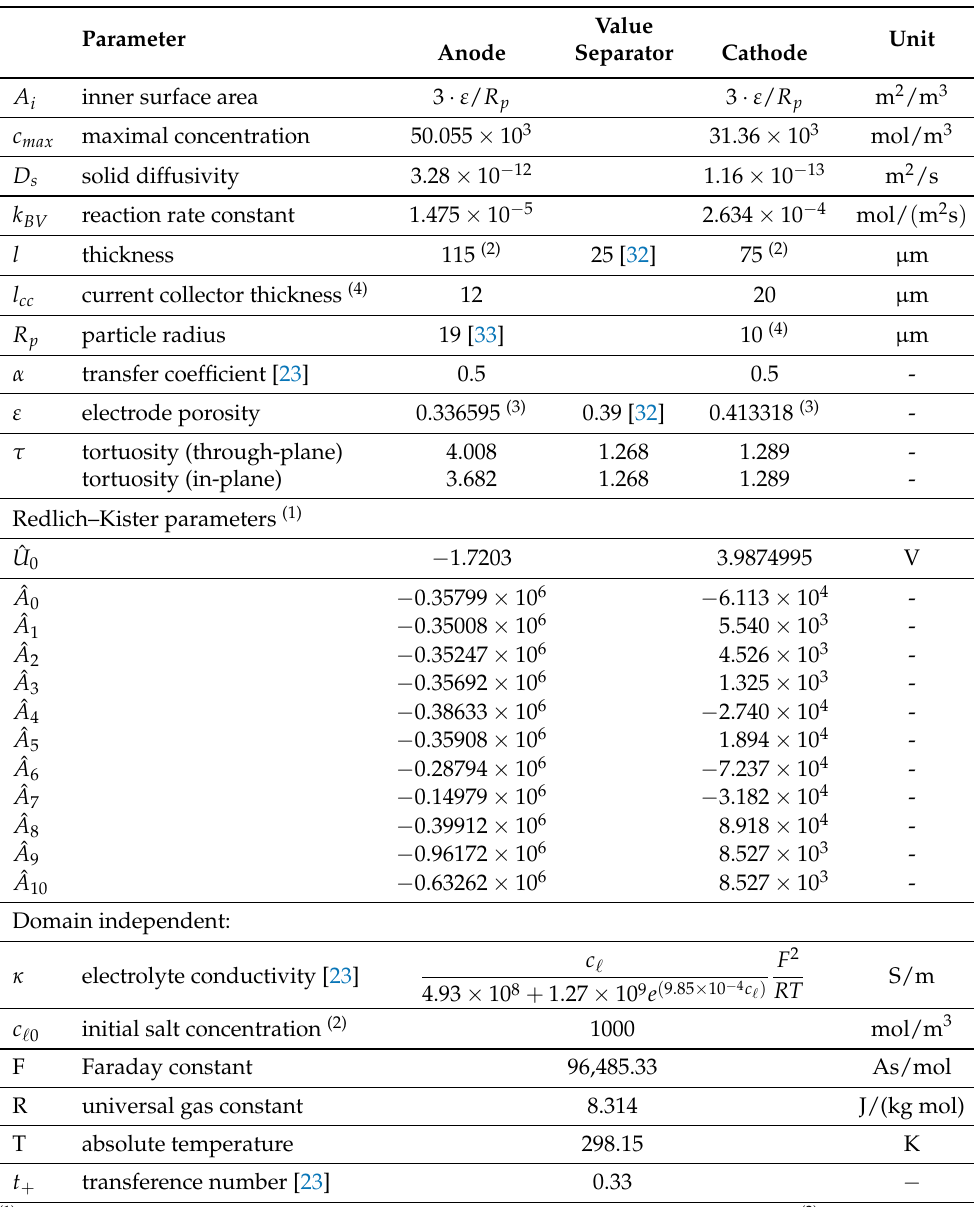
Table 2. Summary of the model parameter values or formulas and an indication of their respective